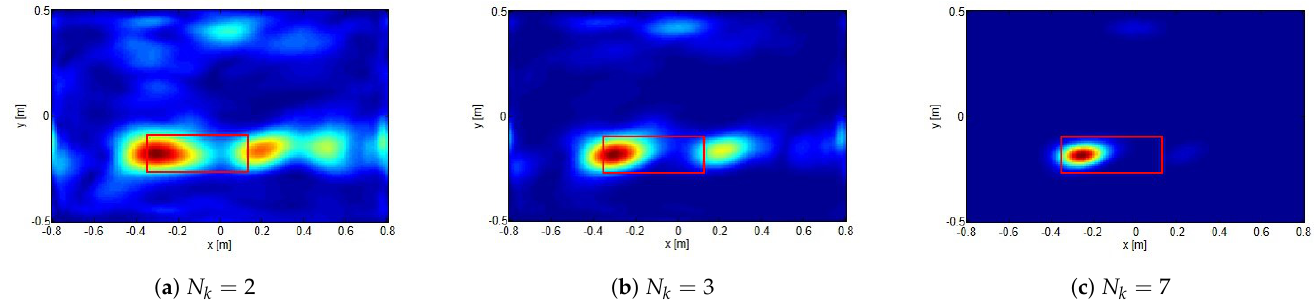
Figure 9. Normalized reconstructions of a shallowly buried target corresponding to the case reported in Figure 7, off- setx = 2.0 m, offsety = 0.3 m but with only 4 × 4 measurement grid collected with a spatial step of 40 cm. The actual target location is denoted as red rectangles. Comparison of reconstructions obtained for different values of N k